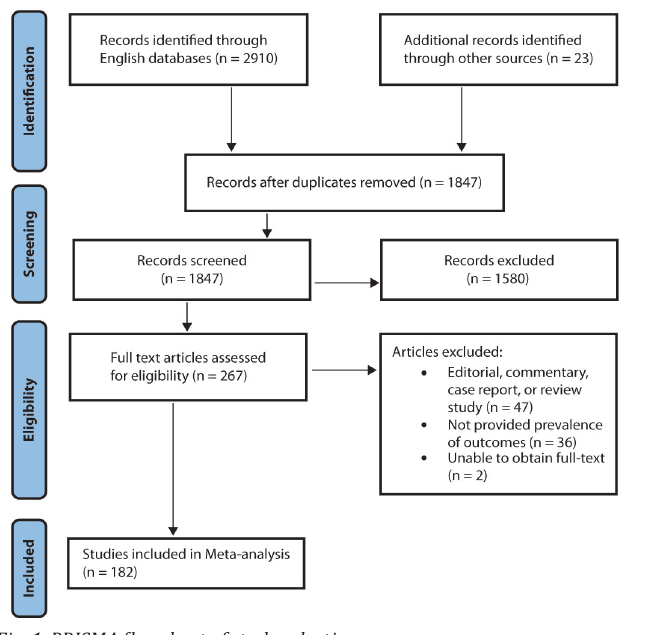
Fig. 1. PRISMA flowchart of study Table 1. Characteristics of the included studies and the Quality score (STROBE score)